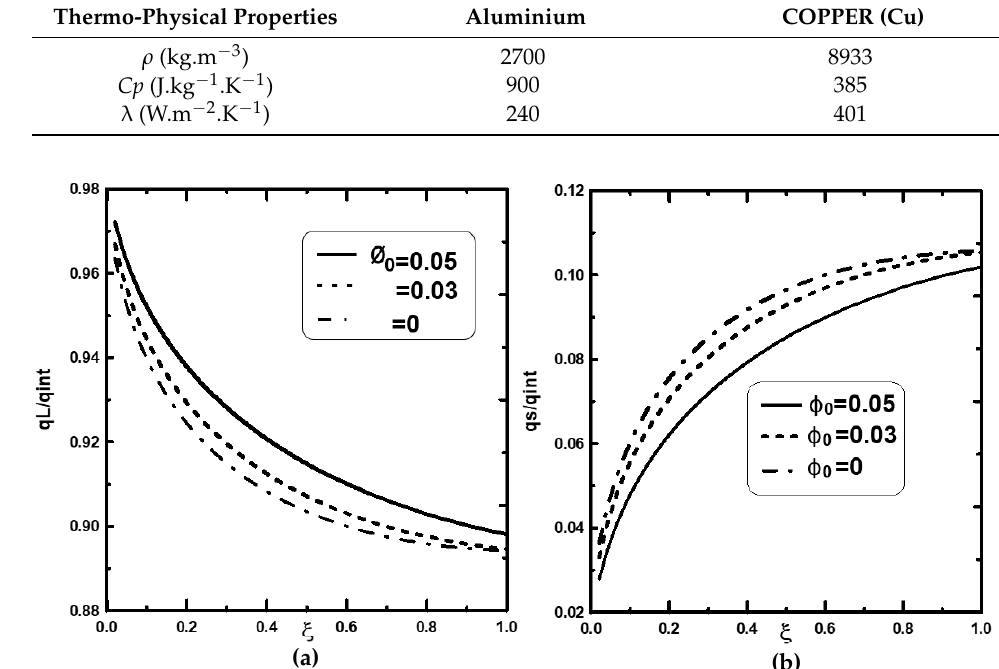
Table 2. Thermo-physical properties (density, heat capacity and thermal conductivity) of the alu- minium and copper nanoparticles at T = 300 K [19].